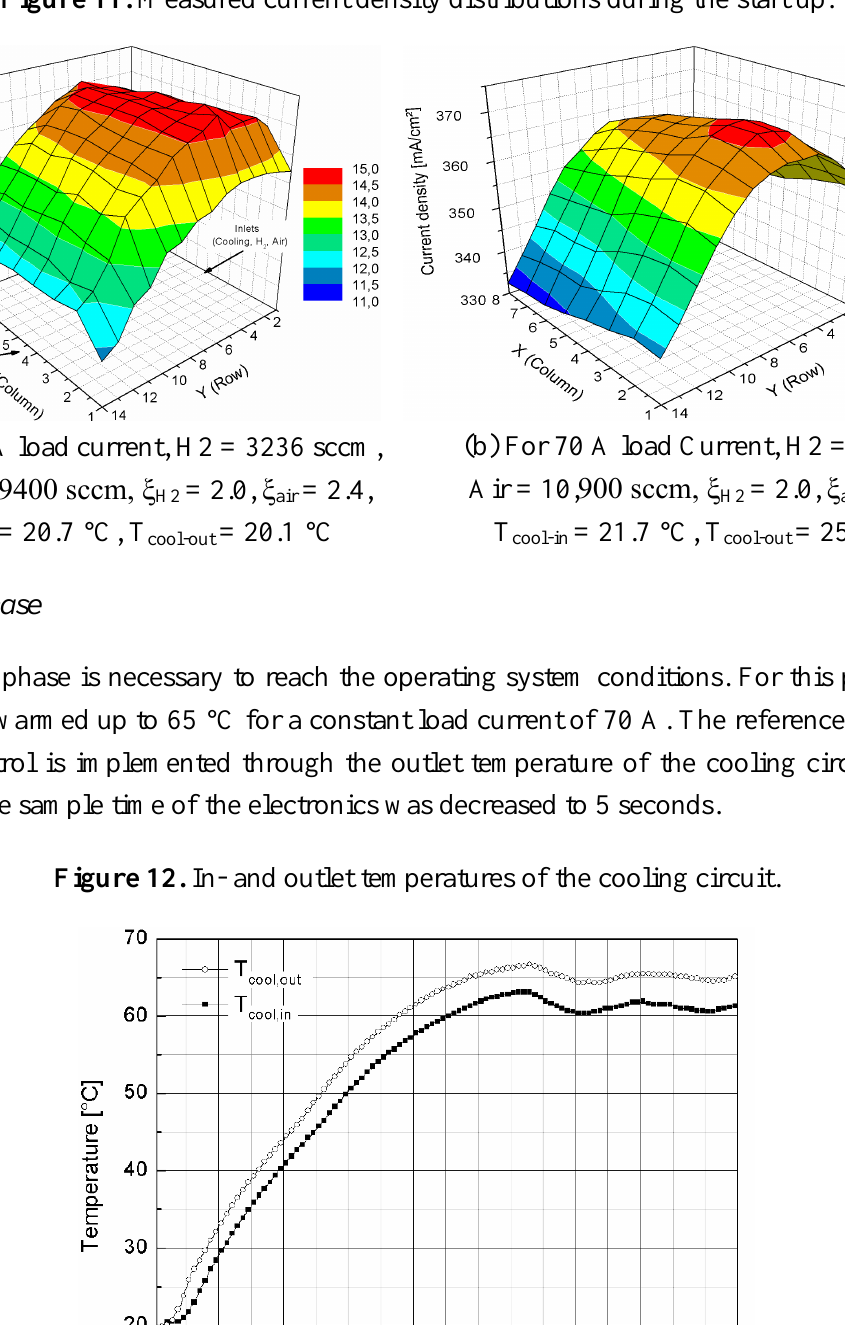
Figure 11. Measured current density distributions during the start up.